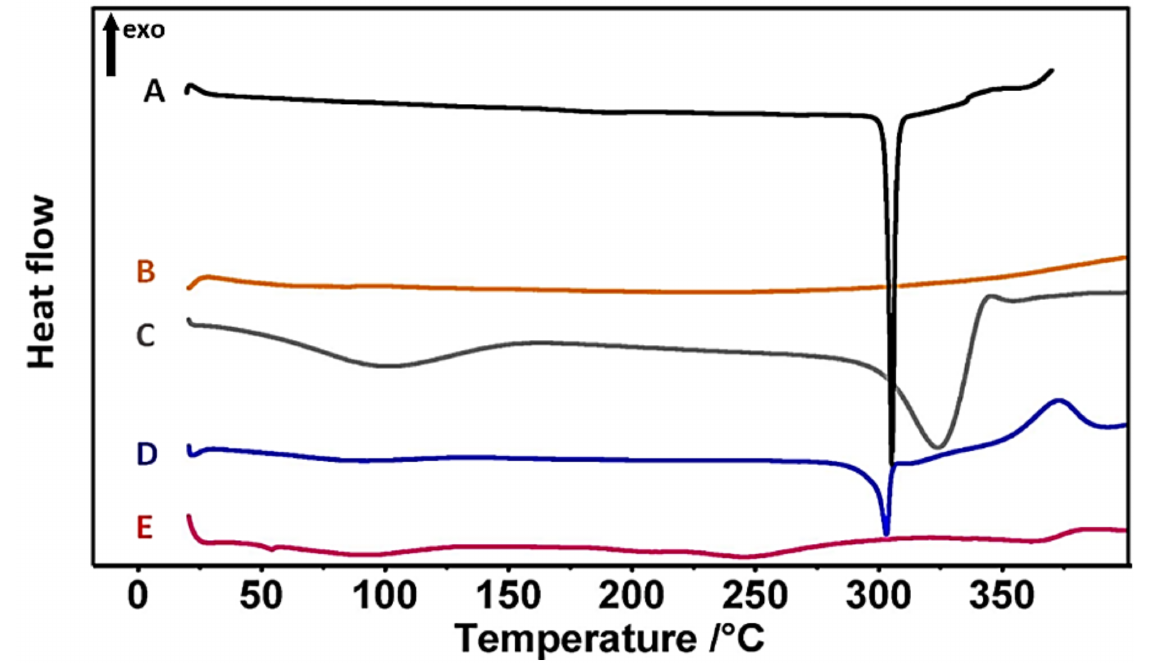
Figure 4. DSC thermograms of tadalafil ( A ), silicon dioxide ( B ), MCC ( C ), physical mixture ( D ), and tadalafil-loaded self-nanoemulsifying granules, SNEG ( E